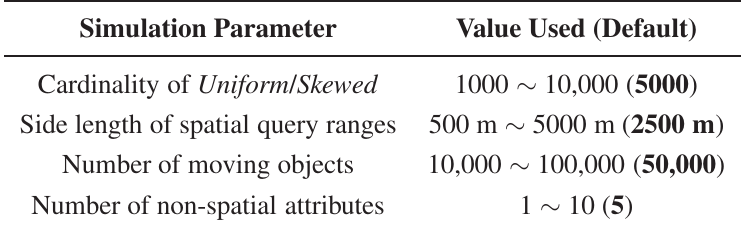
Table 2. Simulation parameters and their values.